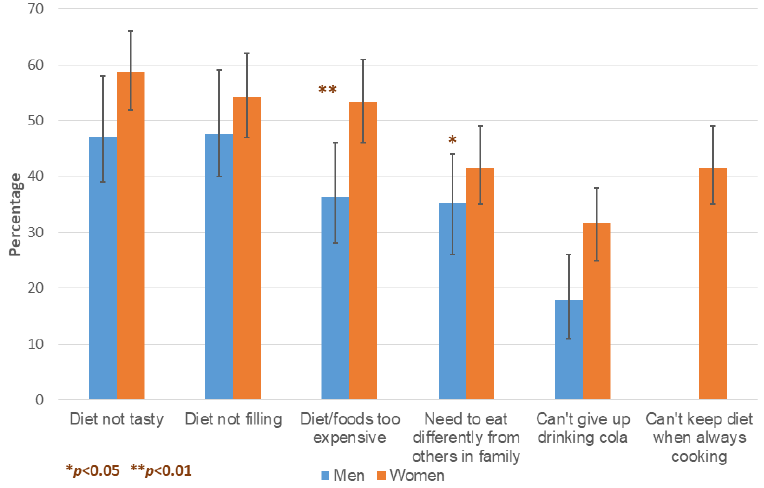
Figure 2. The reported barriers to implementing DM dietary recommendations. The error bars represent 95% confidence intervals.